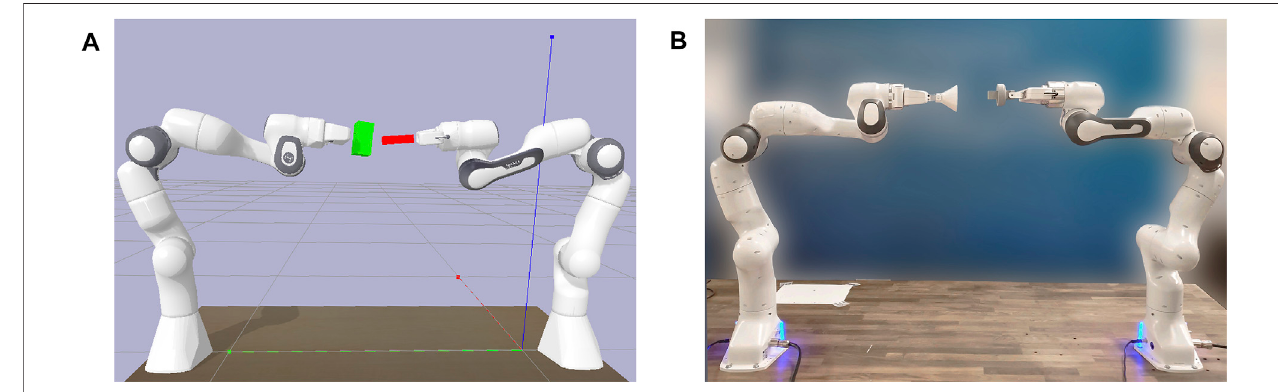
FIGURE1| Simulation-to-realtransfer.Thepolicyistrainedinsimulation (A) toperformdual-armpeg-in-holeandtransferredtotherealworld (B) withoutadditional